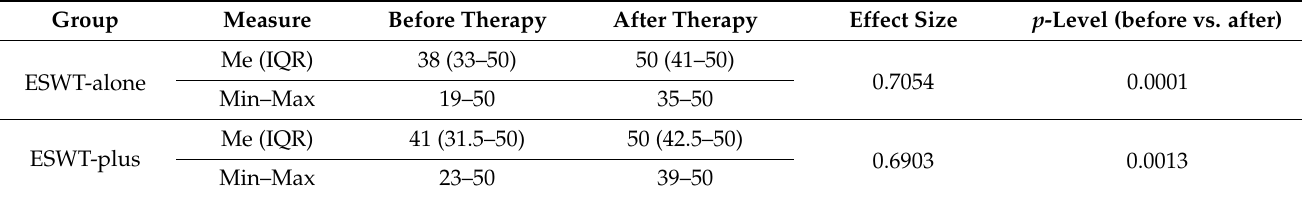
Table 8. Assessment of the AOFAS index (function points) before and after therapy in the compared groups. Group Measure Before Therapy After Therapy Effect Size p -Level (before vs.